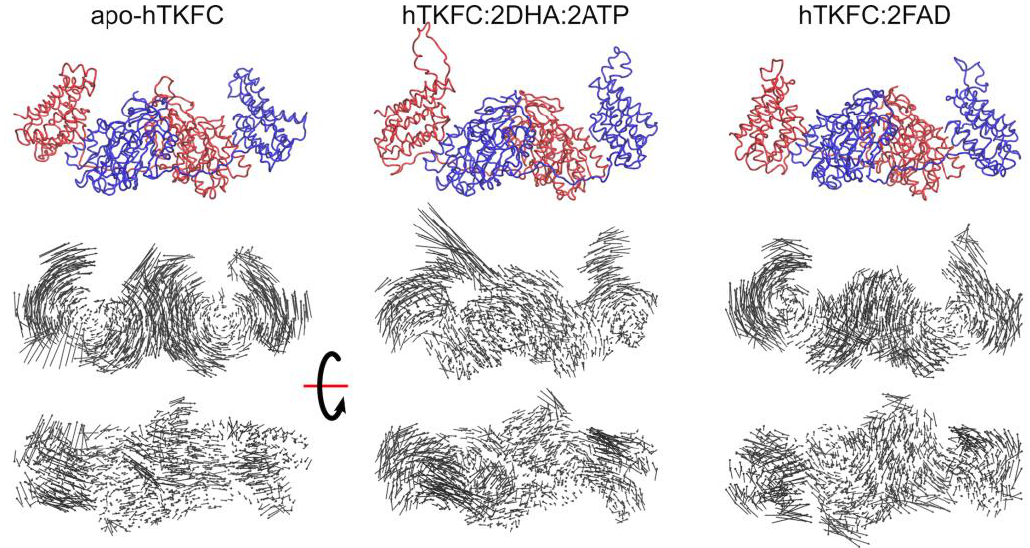
Figure 10. Porcupine representation of principal component 1 for the systems studied. The first line shows the more open of the two extreme conformations defined by the first principal component. The central and lower lines show, respectively, “lateral” and “top” views of the arrow sets indicating the direction and extent of the motion for each C α atom. An animated representation can be seen in Supplemental movie 2.